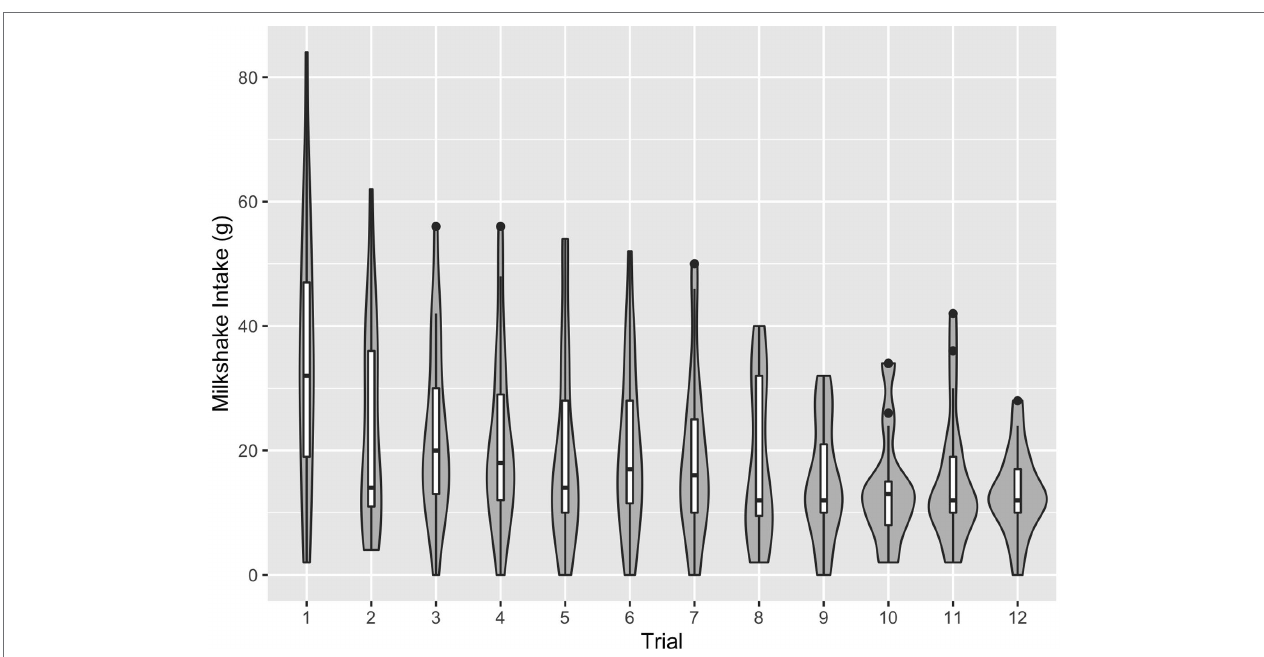
FIGURE 2 | Violin plots of milkshake intake, by trial. Violin plots reveal that median milkshake intake was highest during the first trial and generally decreased thereafter, with reduced variability in later trials.